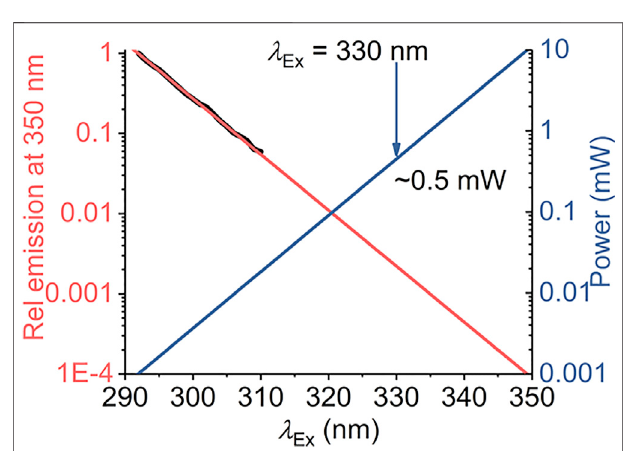
FIGURE 7 | Calculated excitation power requirements to extend protein REES measurements to λ Ex > 310 nm. The black line is the experimentally extracted (natural logarithm) excitation spectrum of protein Trp (single Trp of NEMOasRef.15).Theredlineisthe fi ttoalinearfunction.Thebluelineis the calculated power required to achieve an equivalent emission intensity at increasing values of λ Ex